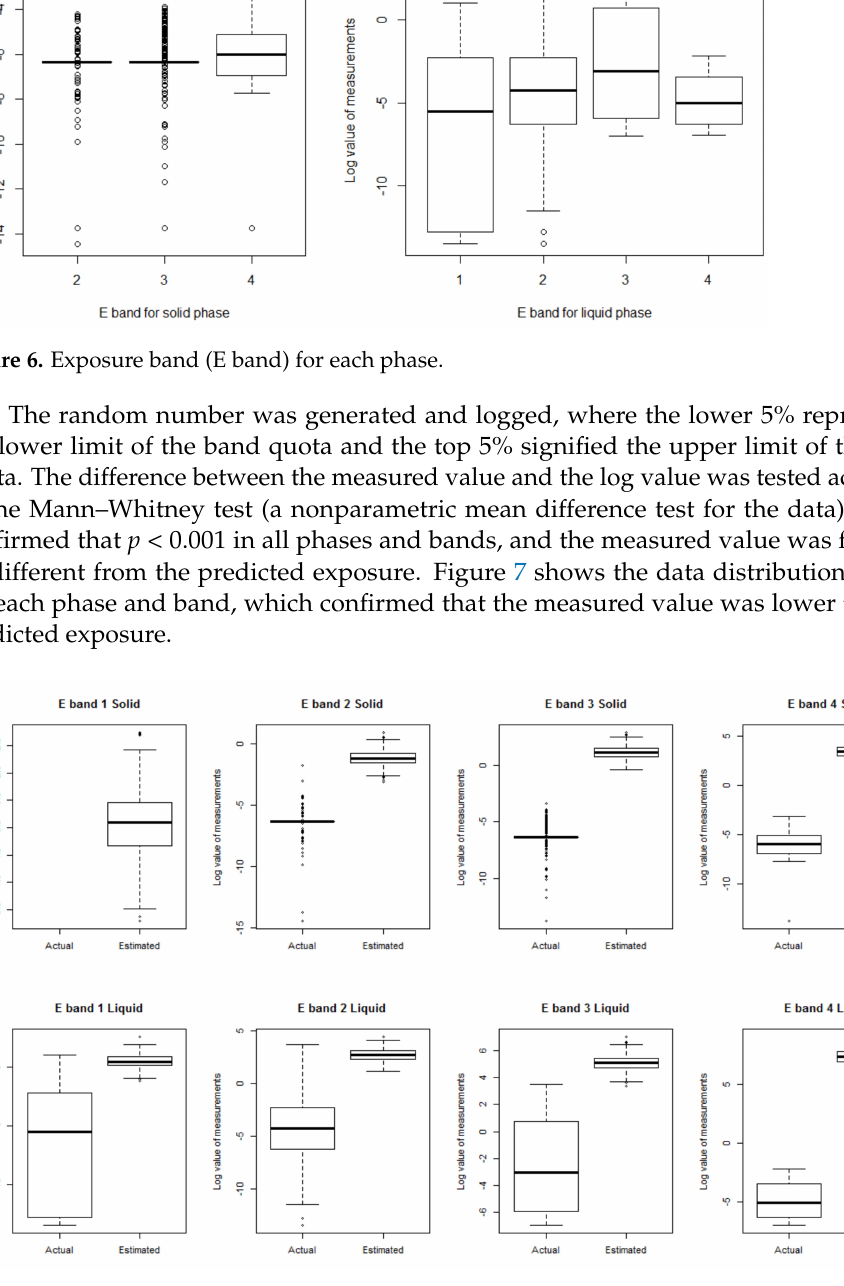
Figure 7. Comparison of actual and estimated exposure for each phase and